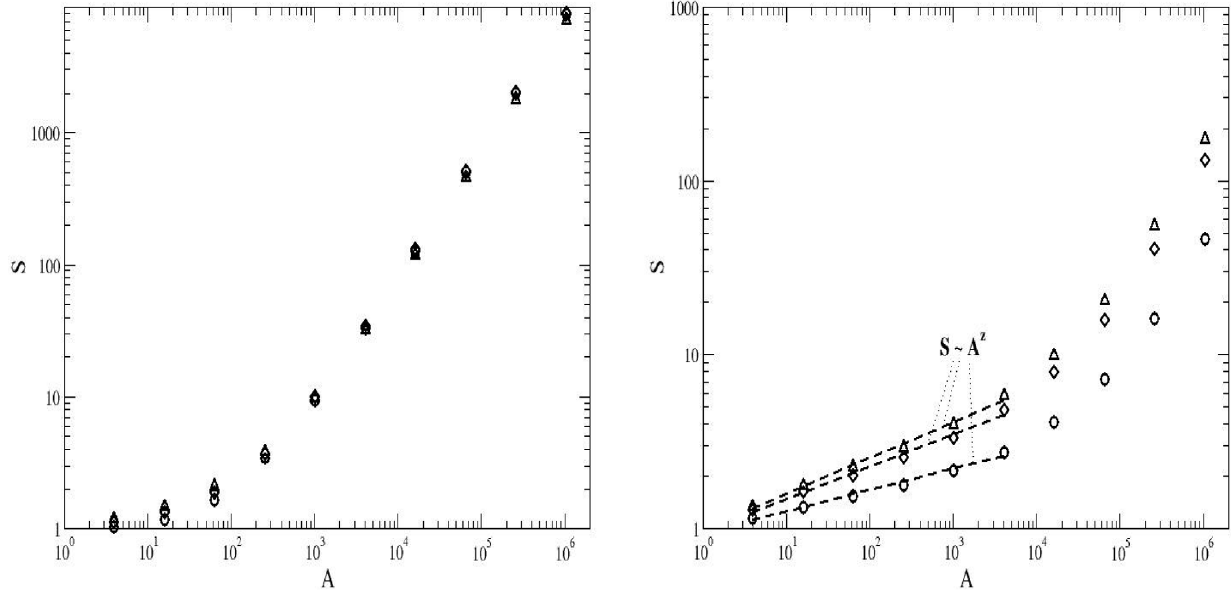
Figure 3. Change of the biodiversity levels with the occupation probability p . The parameter values are lattice size L ~ 1024 , speciation rate n ~ 1 | 10 { 5 , and Hurst exponents H ~ 0 : 1 (left panel) and H ~ 0 : 9 (right panel). The occupation probabilities are p ~ 0 : 3 (circles), p ~ 0 : 5927 (triangles) and p ~ 0 : 7 (diamonds). The data points represent an average over 50 independent runs. The error bars are smaller than the symbols.